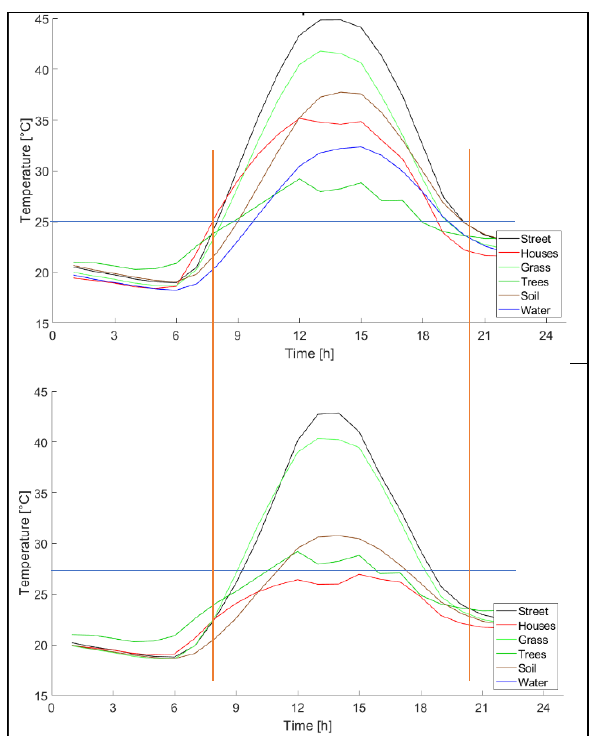
Figure 6: Average temperatures of all surfaces for the current model (top) and alternative model